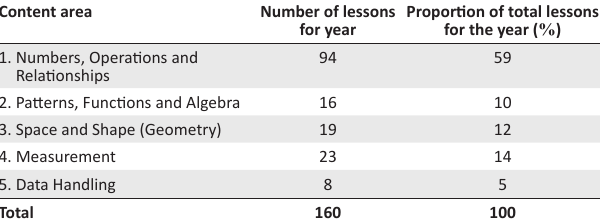
TABLE 4: CAPS Recommended number of lessons per Content Area for Grade 3